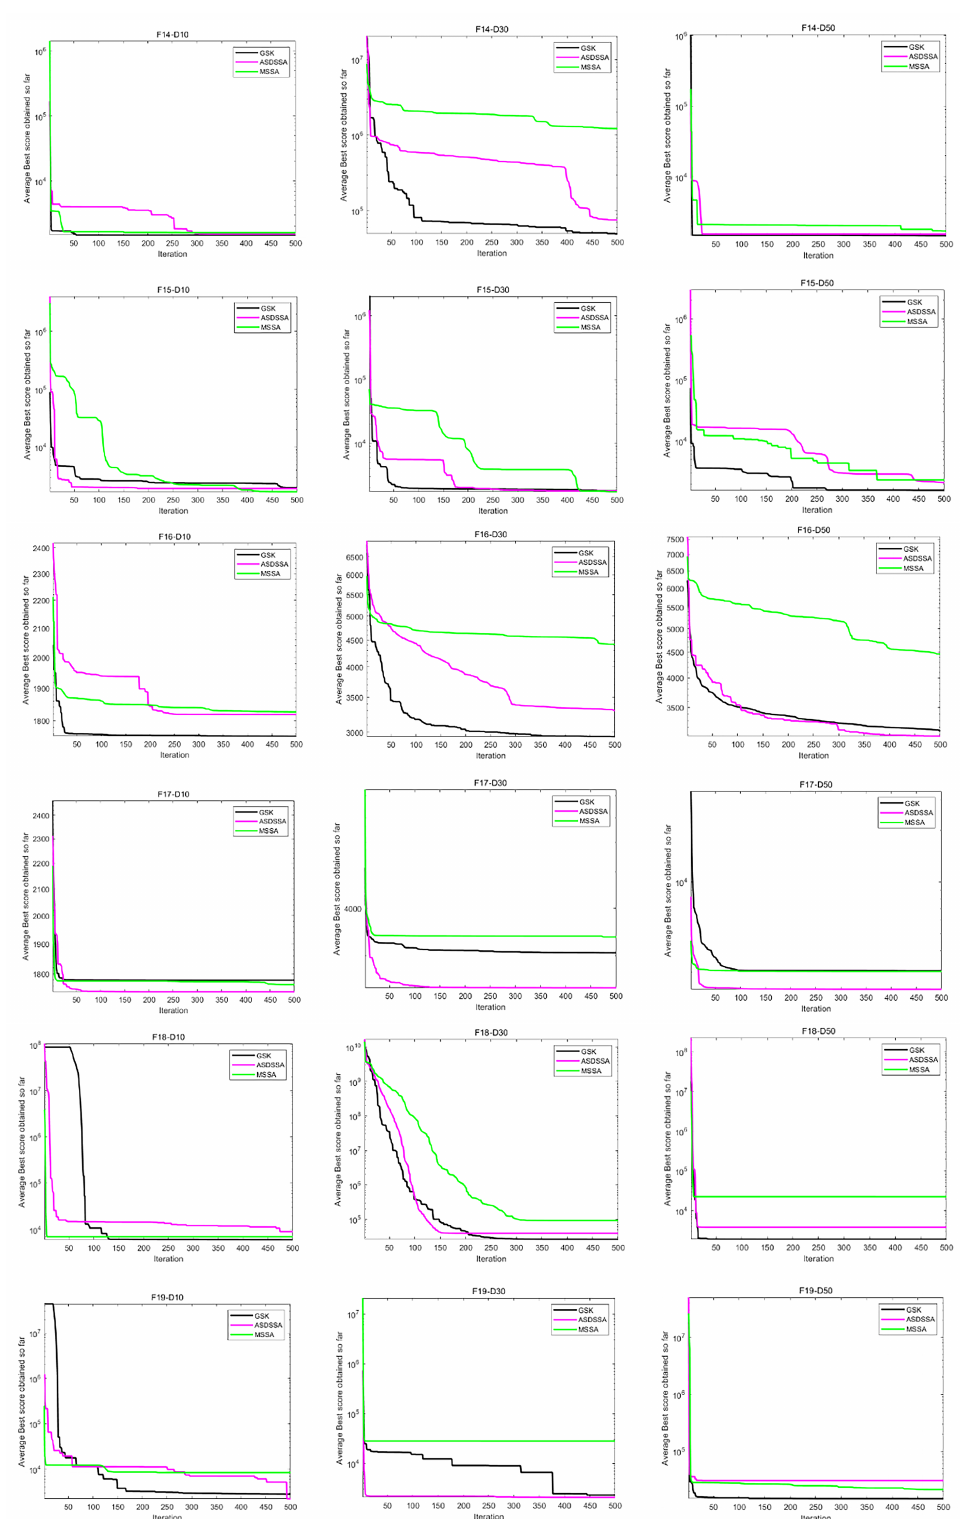
Figure 7. Convergence curves of